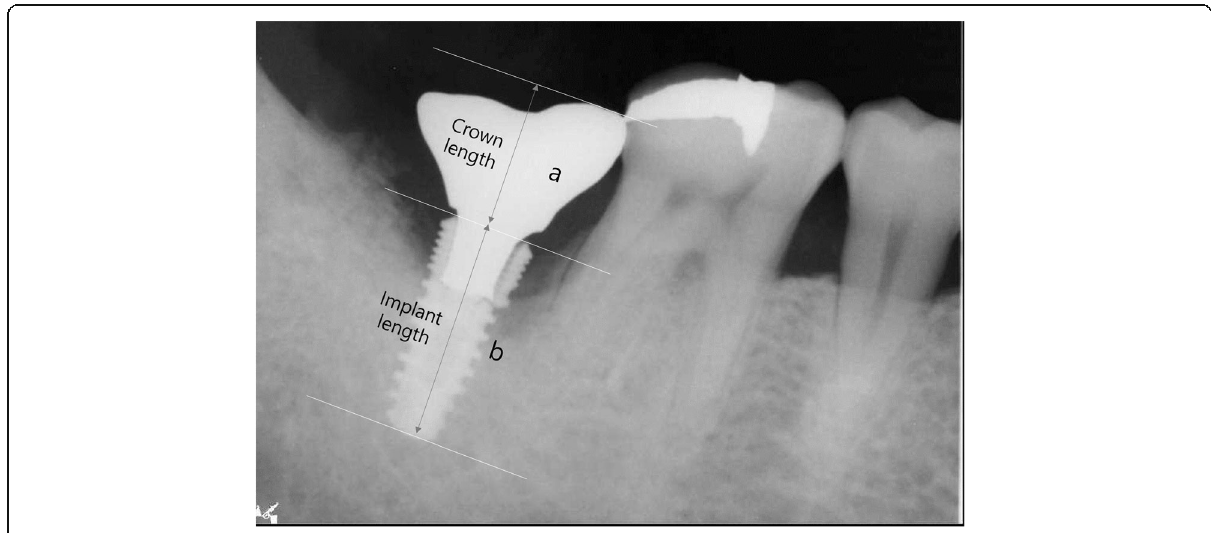
Fig. 2 The method of measuring the crown/implant ratio